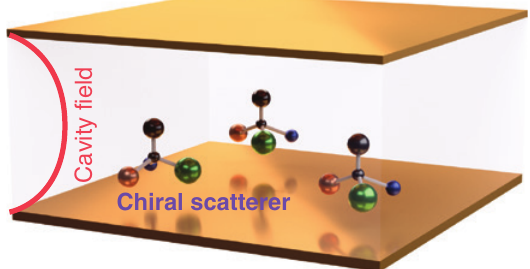
Figure 1: Sketch of the system under study: chiral scatterers are placed inside a planar